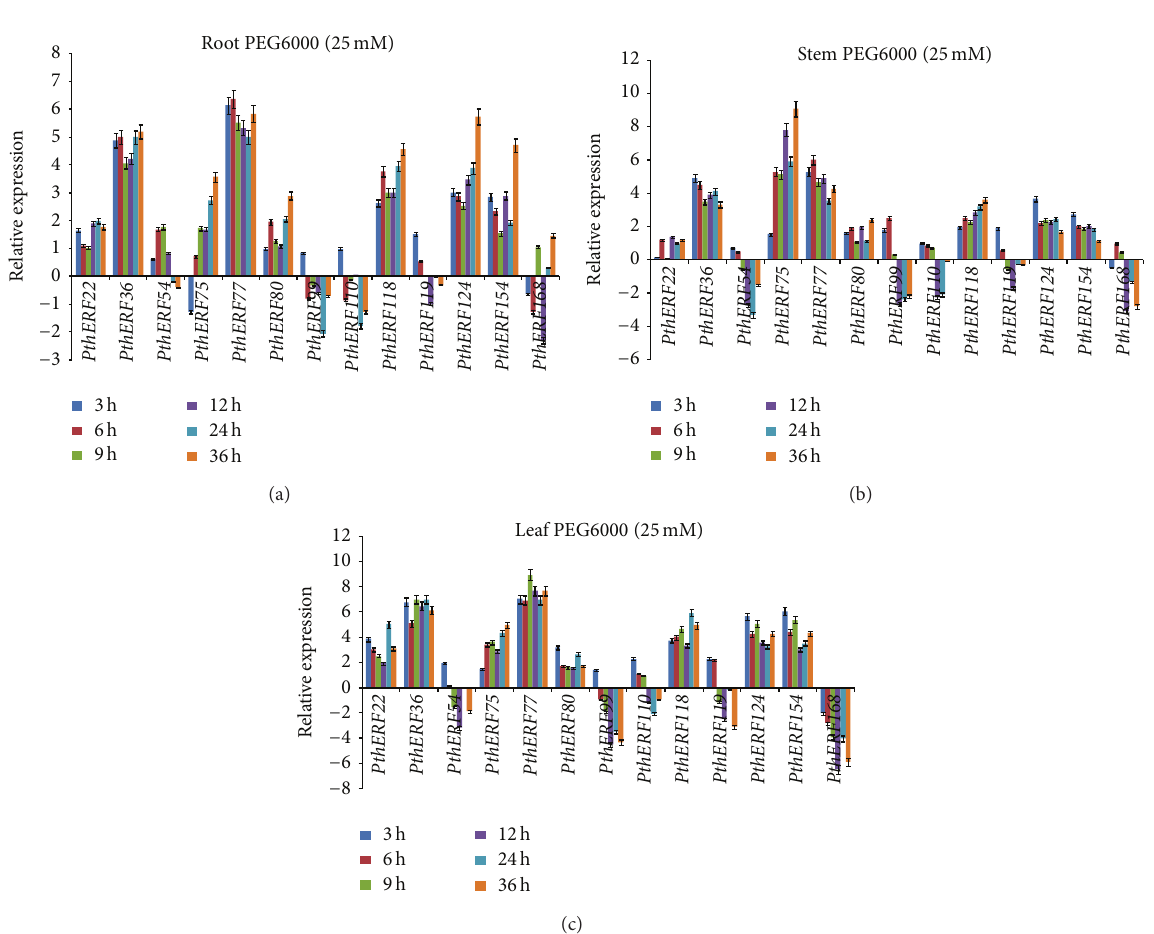
whose expression was the highest in the stems. The expression level of PthERF118 in stem was 215 times of that in roots and 11.5 times in leaves. Such results suggest that the PthERFs may play roles mainly in stems rather than in roots and